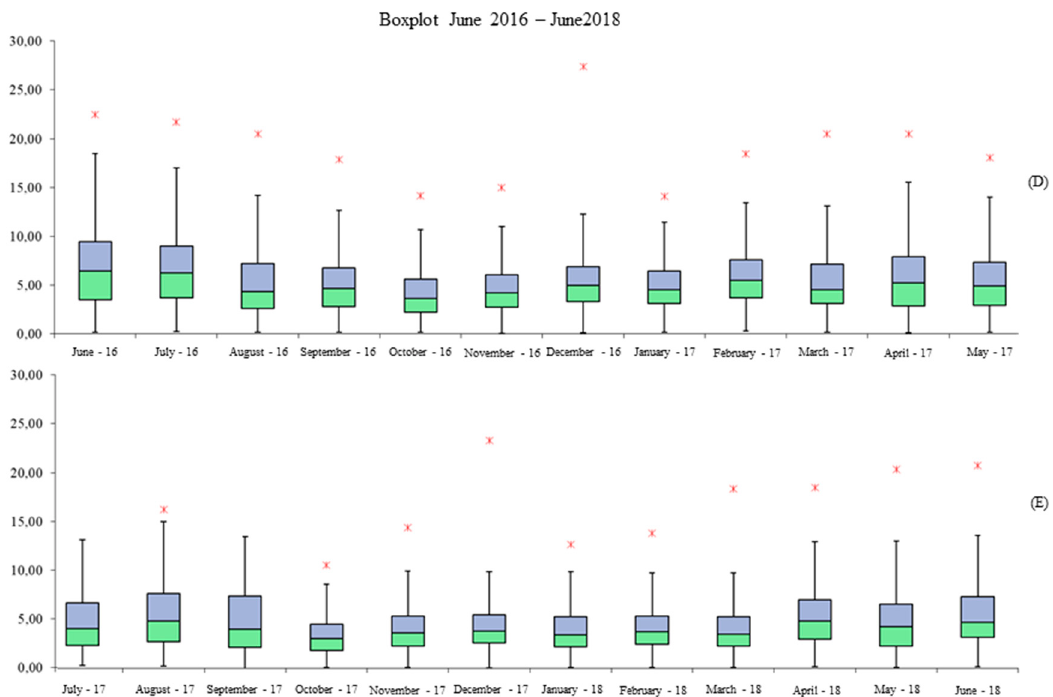
Figure 3. Statistical evaluation of the wind speed. ( A ) Weibull distribution for June–December 2016;